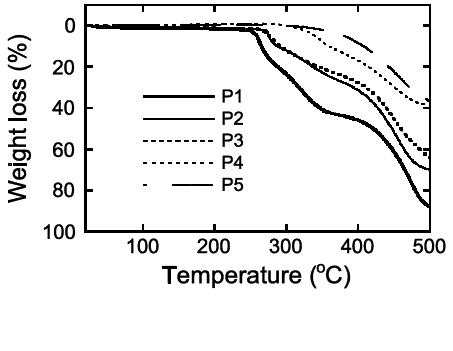
Figure 3. Thermogravimetric analysis (TGA) curves of P1–P5 at a heating rate of 10 °C min −1 under flowing